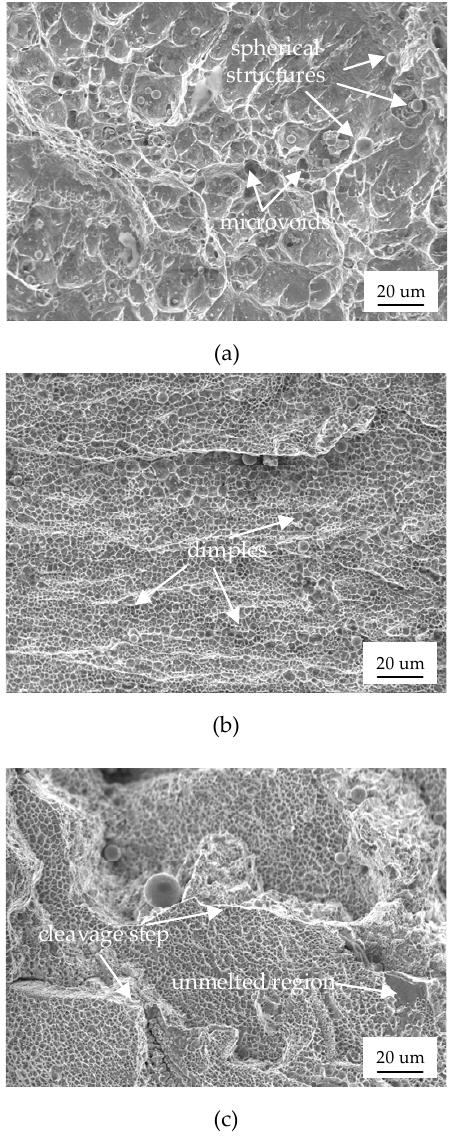
Figure 8. The SEM images of the micro-morphology fracture surface of the tensile specimens: ( a – c ) specimens 1, 2, and 3, respectively.